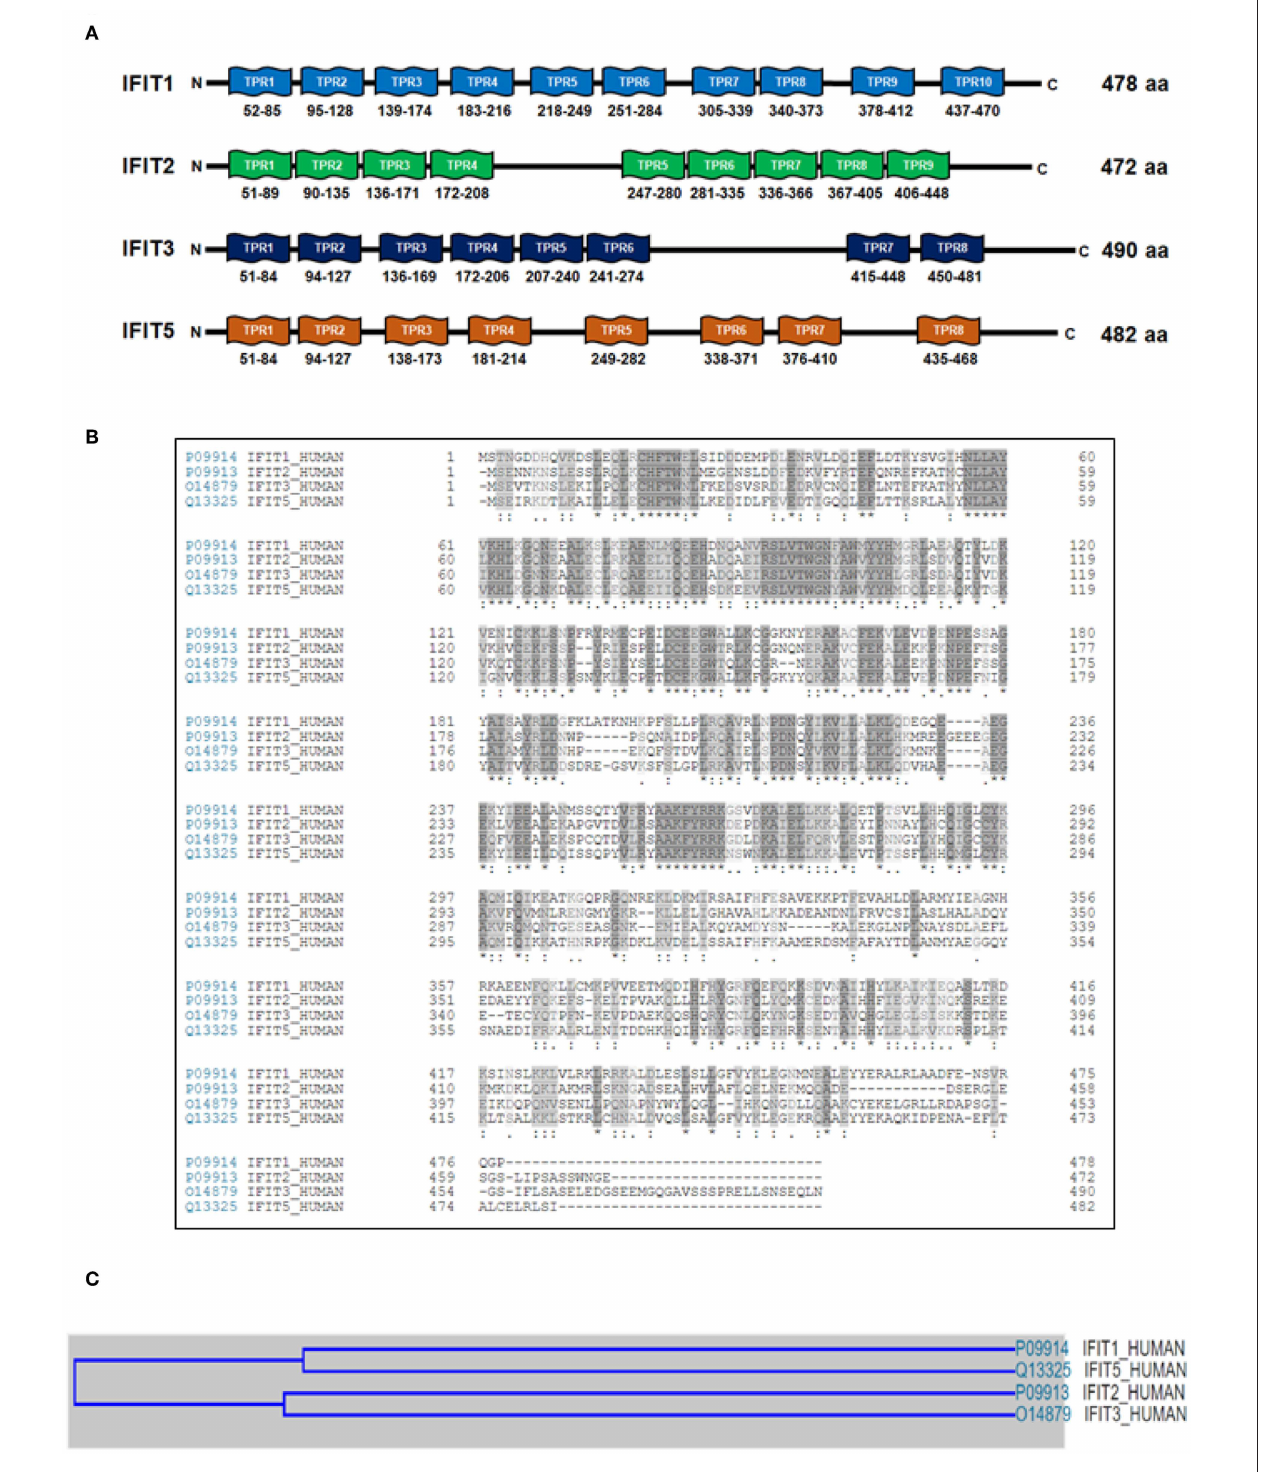
Frontiers in Molecular Biosciences | www.frontiersin.org